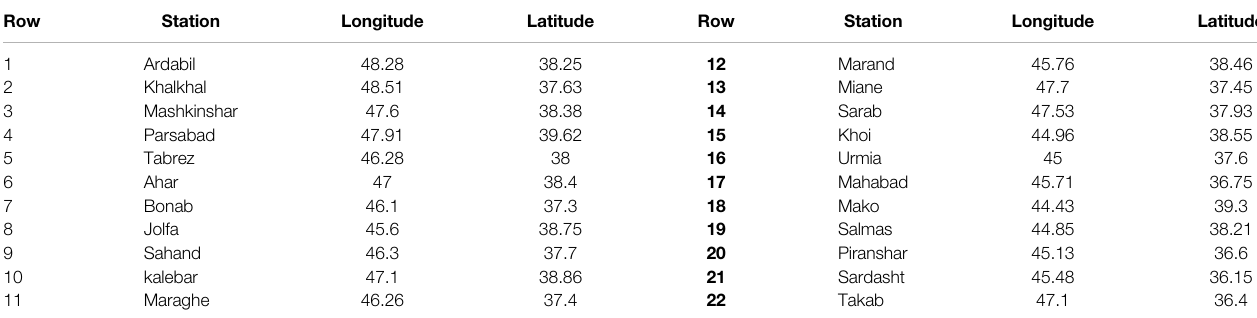
TABLE 1 | Geographical coordinates of the studied synoptic